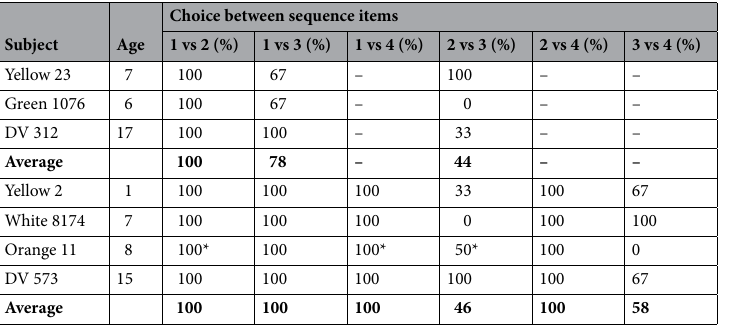
Table 2. Percentage of trials (out of three trials) during which a subject chose the item that had appeared earlier in the sequence. Individuals are listed in order of the number of items they received during training; those that only completed up to TS3 were not presented with choices including sequence item 4. *Based on two trials instead of